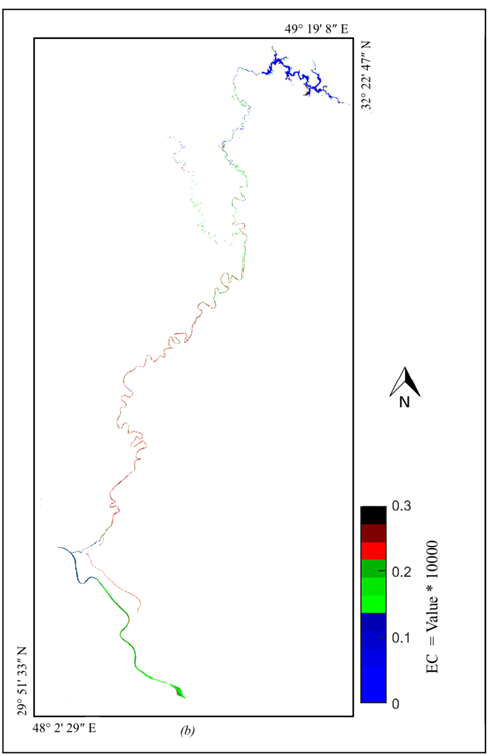
Figure 6. The water salinity map from the SVR model, (a) on 1 February 2015, (b) on 5 September